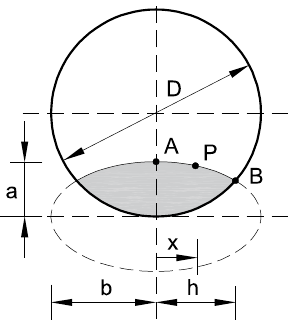
Figure 2: Elliptical crack model used by Shin and